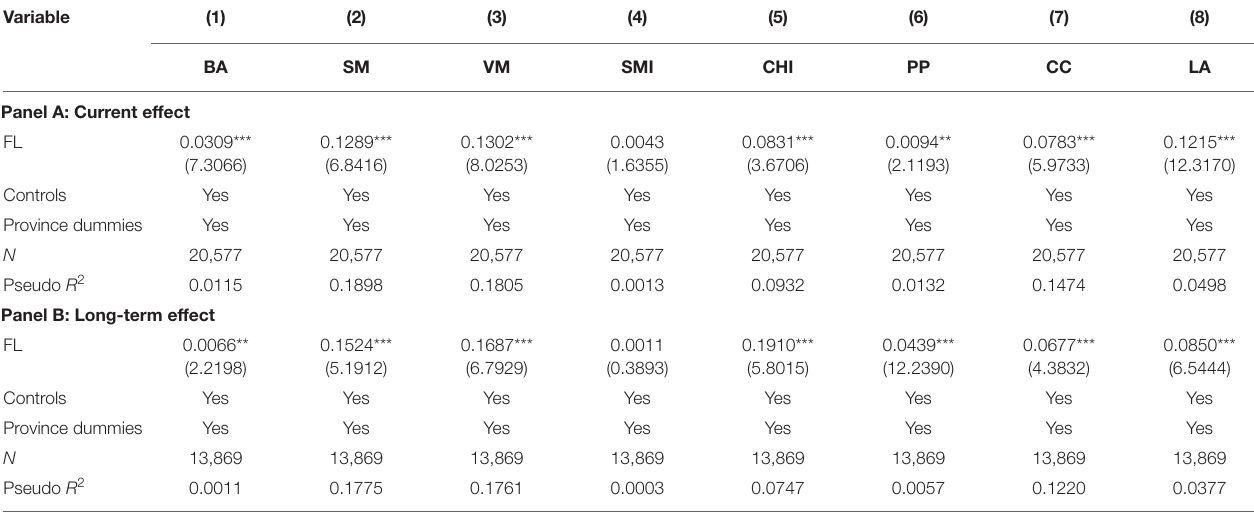
TABLE 13 | Robust test by estimation using the Poisson model.